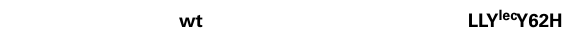
Table 3 | Cumulative totals of bound Lewis antigen over the course of 100 independent, 30 ns simulations starting from the Lewis bound